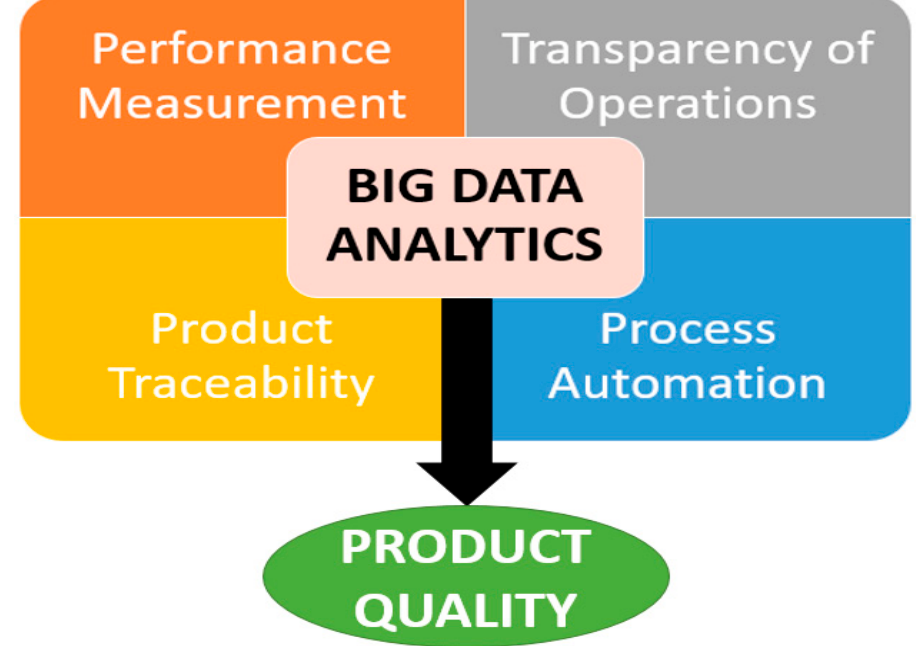
Figure 4. Big data analytics to improve product quality for AM parts.